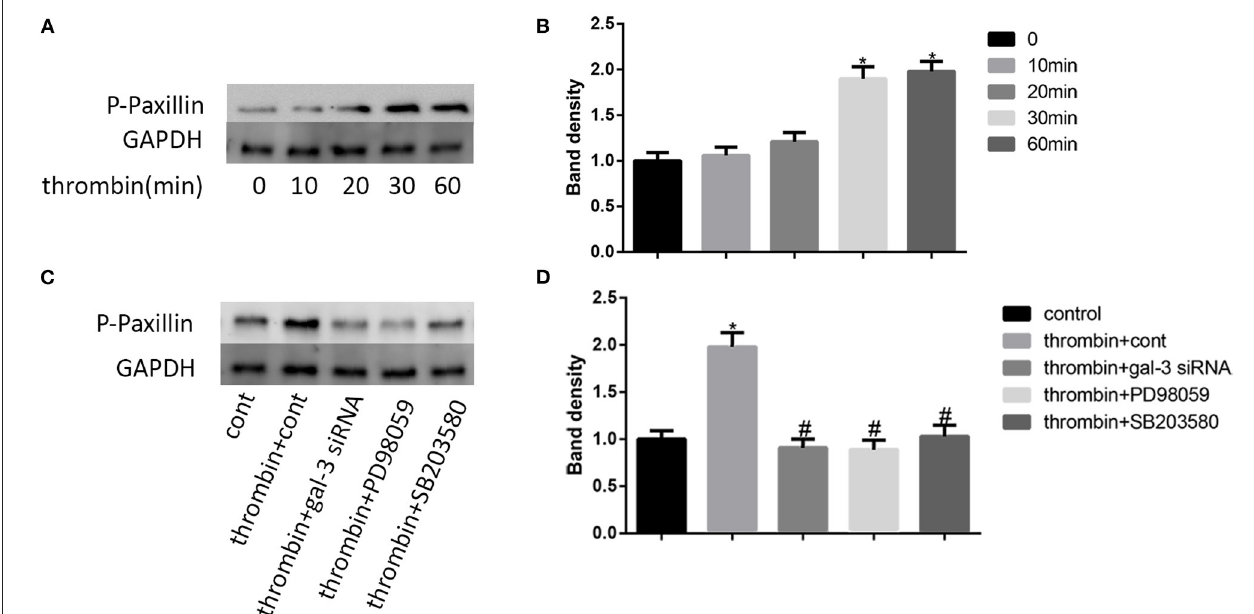
FIGURE 4 | Thrombin promoted paxillin phosphorylation via ERK/P38 signaling pathway. VSMCs were treated with thrombin (2 U/ml) for different times (0, 10, 20, 30, and 60min) and the expression of p-paxillin was measured by Western blot (A,B) . Cells were treated with gal-3 siRNA, PD98059, or SB203580, and then incubated in the absence or presence of thrombin (2 U/ml). The expression of p-paxillin was measured by Western blot (C,D) . Quantification of the results is shown in the right panel. Band density of native VSMCs was defined as a control and considered to 1. * p < 0.05 vs. control; # p < 0.05 vs. thrombin.